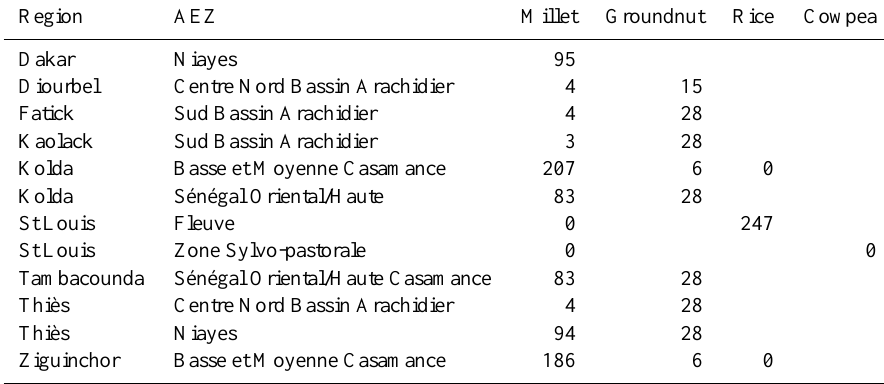
Table 3. NPK applications (kgha − 1 ) for millet groundnut, rice, and cowpea.